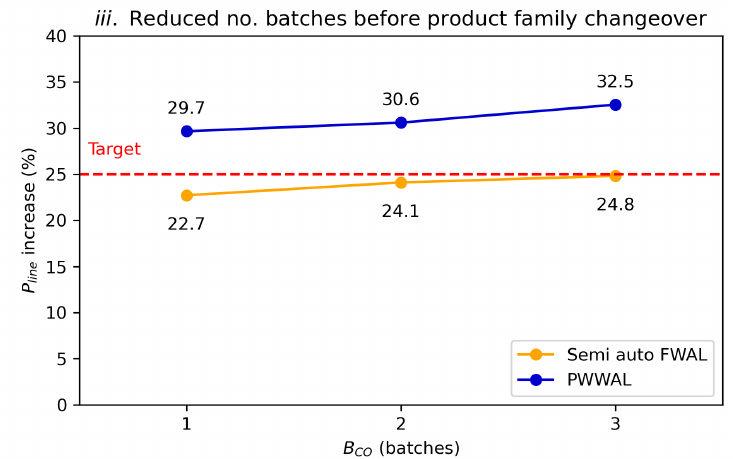
Figure 5. Line productivity improvement of semiautomated FW and parallel walking-worker with respect to manual FW line configuration for reduced no. of batches until product family changeovers ( B CO , scenario iii